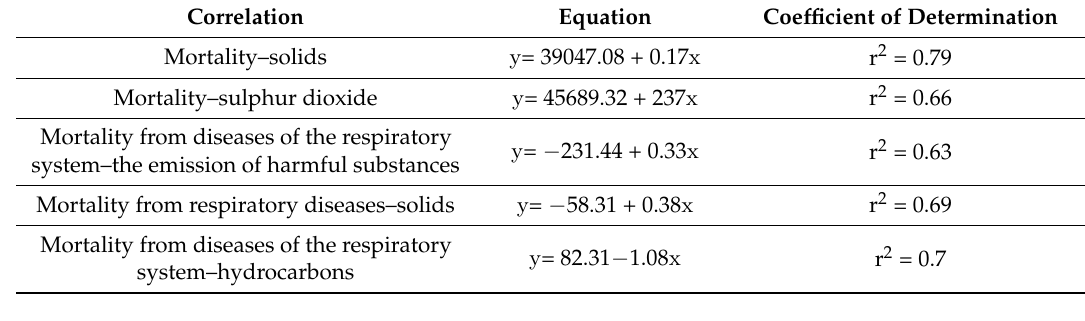
Table 2. Dependence of mortality on emissions of harmful substances.